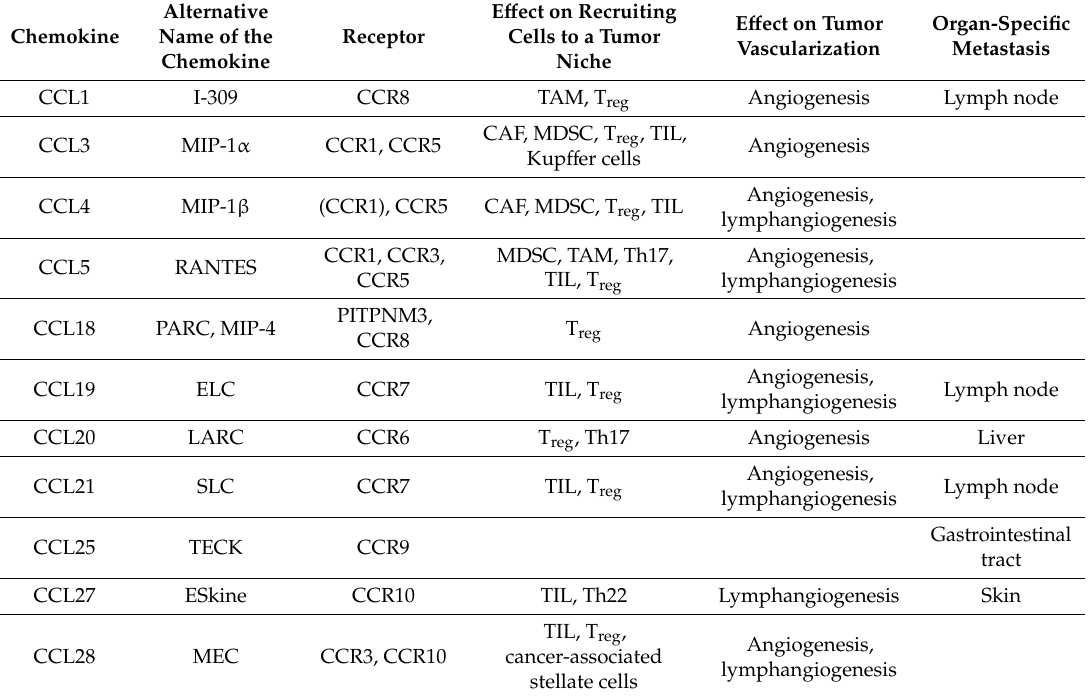
CAF—cancer-associated fibroblasts; MDSC—myeloid-derived suppressor cells; PITPNM3—phosphatidylinositol transfer protein 3; TAM—tumor-associated macrophages; Th17—T helper 17; TIL—anti-cancer tumor-infiltrating lymphocytes; T reg —regulatory T